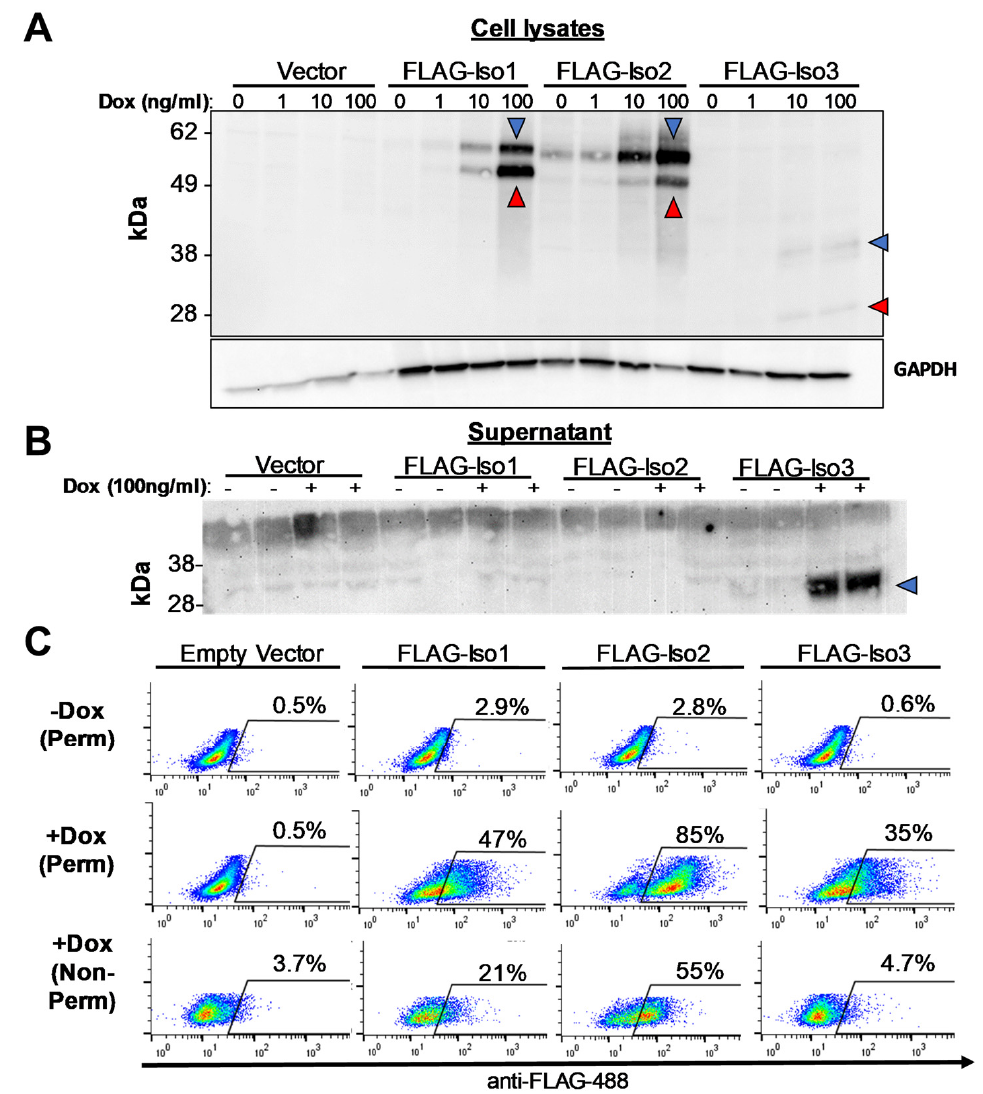
Figure 2. Doxycycline-inducible expression of FLAG-IFNLR1 isoforms in HEK293T cells. ( A , B ) Dox- inducible expression of IFNLR1 isoforms in stable HEK293T clone cell lysates ( A ) and culture supernatant ( B ) was detected by western blot using anti-FLAG antibody. Predicted non-glycosylated and glycosylated proteins are denoted by red and blue arrows, respectively. ( C ) Percent of FLAG-positive cells after 24 h induction ± dox (100 ng/mL) followed by permeabilization (perm) or no permeabilization (non- perm), staining with anti-FLAG antibody, and analysis by flow cytometry (representative data, three independent experiments).